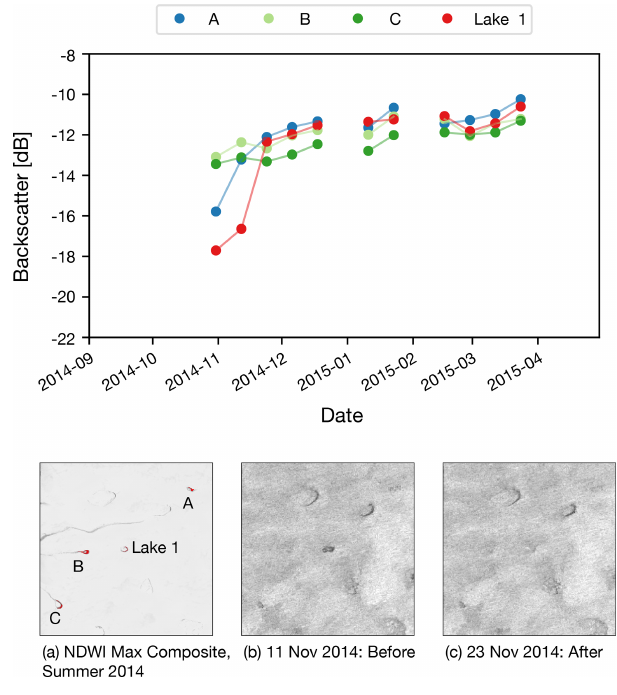
Figure D1. Lake 1 surrounding lakes.